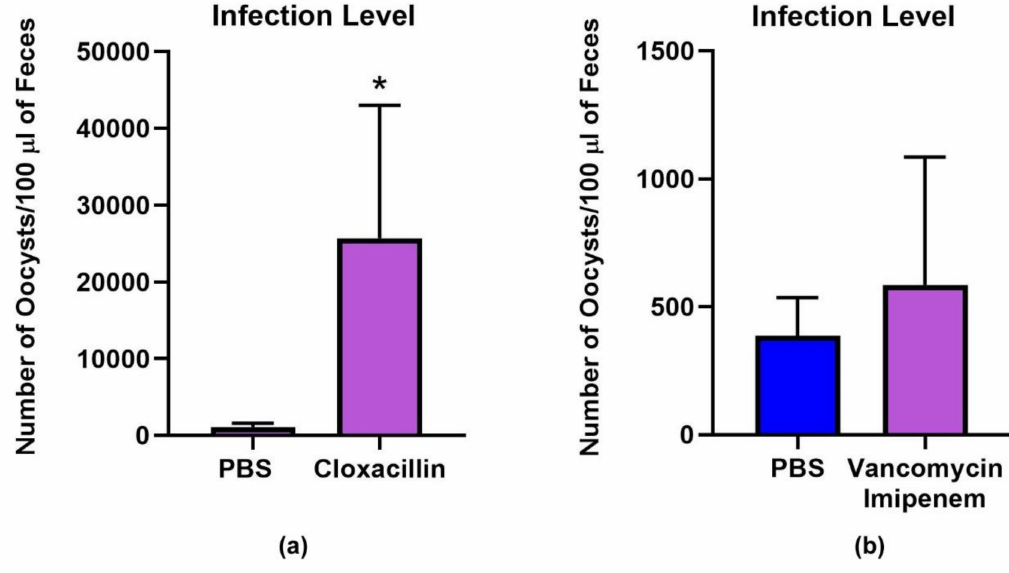
Figure 1. Parasite load in C. parvum -infected mice. Mice were infected with 10 3 C. parvum oocysts and treated with either vehicle control (sterile water), cloxacillin or vancomycin-imipenem. ( a ) a significant increase in infection level was observed in the cloxacillin treated group ( p < 0.0019, Mann–Whitney); ( b ) No significant di ff erence was observed in mice infected with 10 3 C. parvum oocysts and